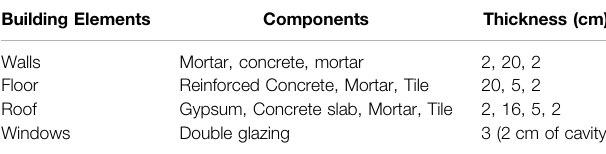
TABLE 4 | Typical Moroccan building envelope components.